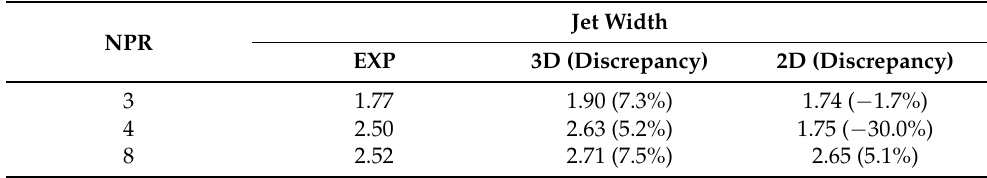
Table 5. Jet width at 2 H t location from exit of the ramp section.